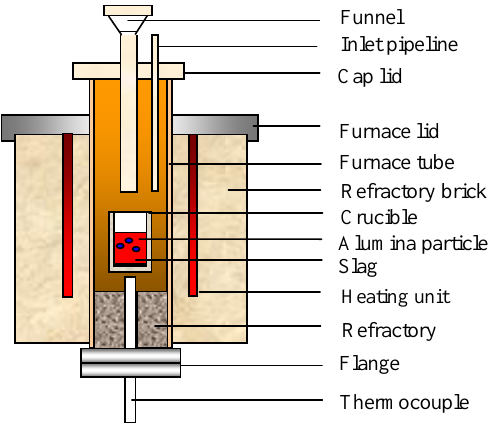
Figure 1. Schematic of experimental apparatus.